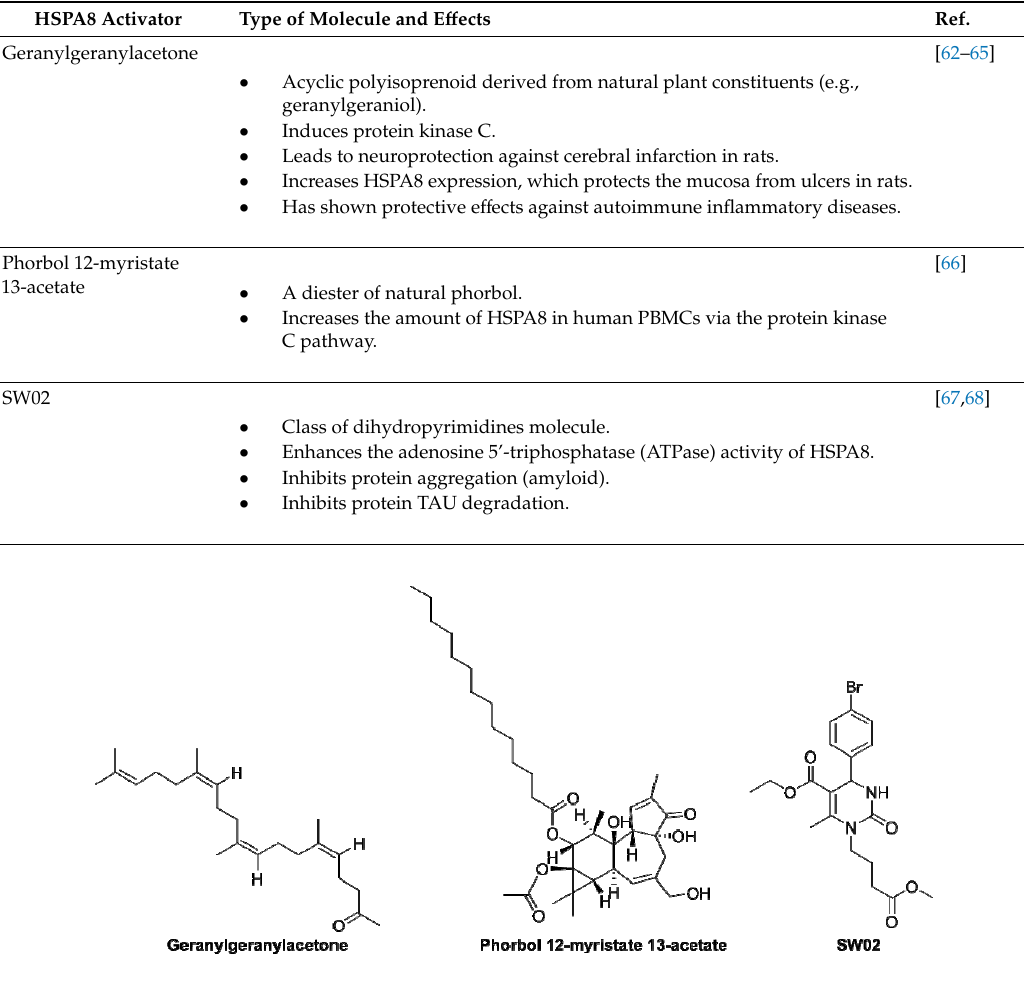
Figure 3. Structures of HSPA8 activators.